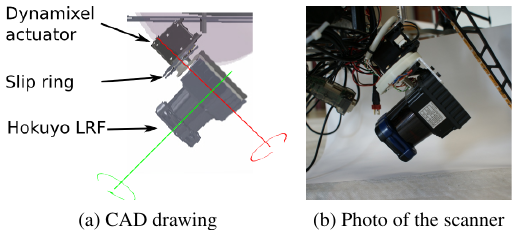
Figure 4: CAD drawing (a) of the continuous rotating laser scan- ner with the two rotation axis with the Hokuyo 2D LRF mounted on a bearing and rotated around the red axis and photo of the assembled laser scanner